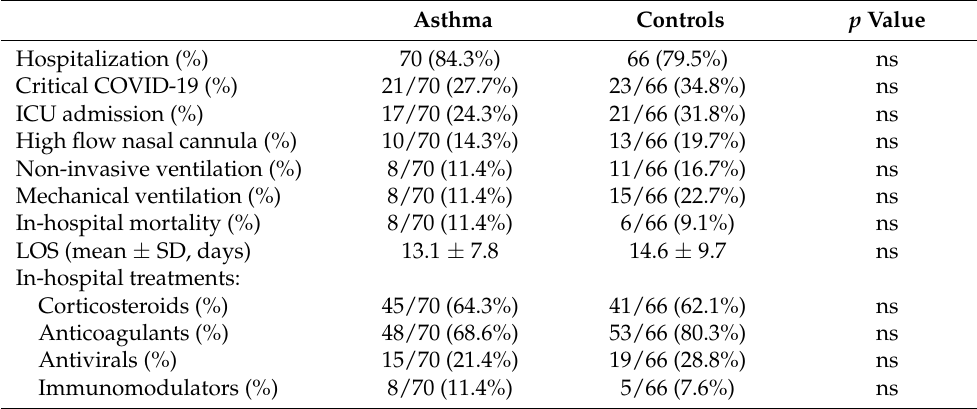
Table 2. Clinical outcomes in COVID-19 patients, with and without asthma, and the most common pharmacologic treatments for COVID-19 administered to the hospitalized patients. The p -value describes the level of statistical significance in the univariate analysis. Abbreviations: ICU, intensive care unit; LOS, length of stay.